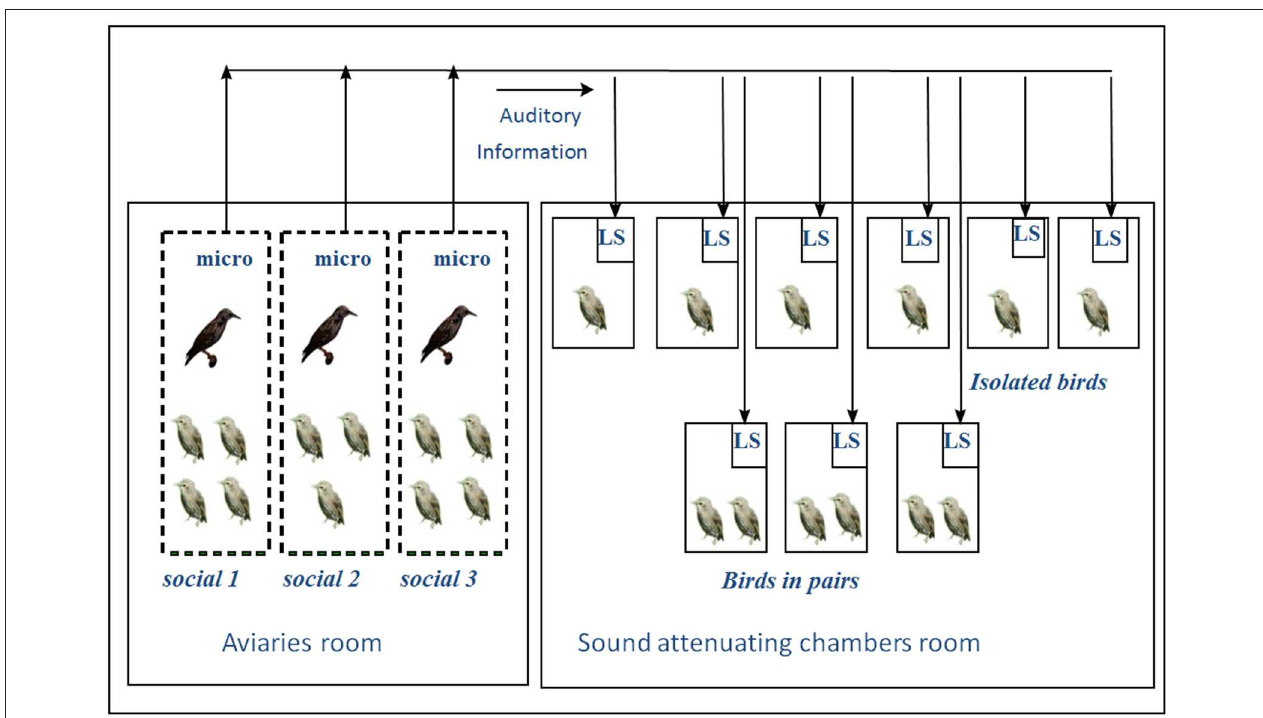
FIGURE 9 | Experimental set-up: In the aviary room, young birds housed in the three different aviaries could hear and see each other. In the soundproof chambers, birds were housed individually or in pairs. All the experimental birds received the same auditory exposure. Birds in the soundproof chambers could hear all the songs from the birds in the aviaries via microphones and loudspeakers. (M, wild males; m, experimental males; f, experimental females; LS, loudspeaker; micro, microphone; → , direction of auditory information transfer (from Poirier et al., 2004).